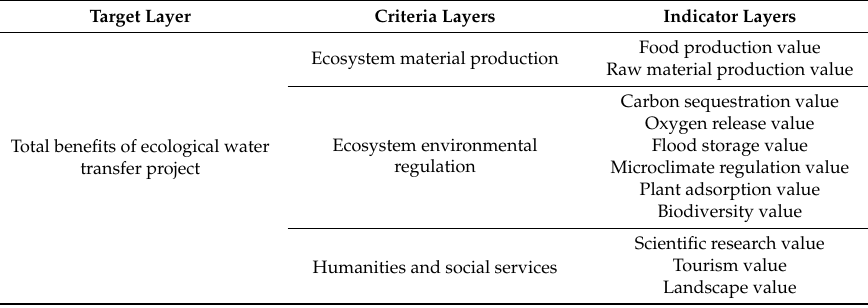
Table 1. Wetland ecological service function evaluation index